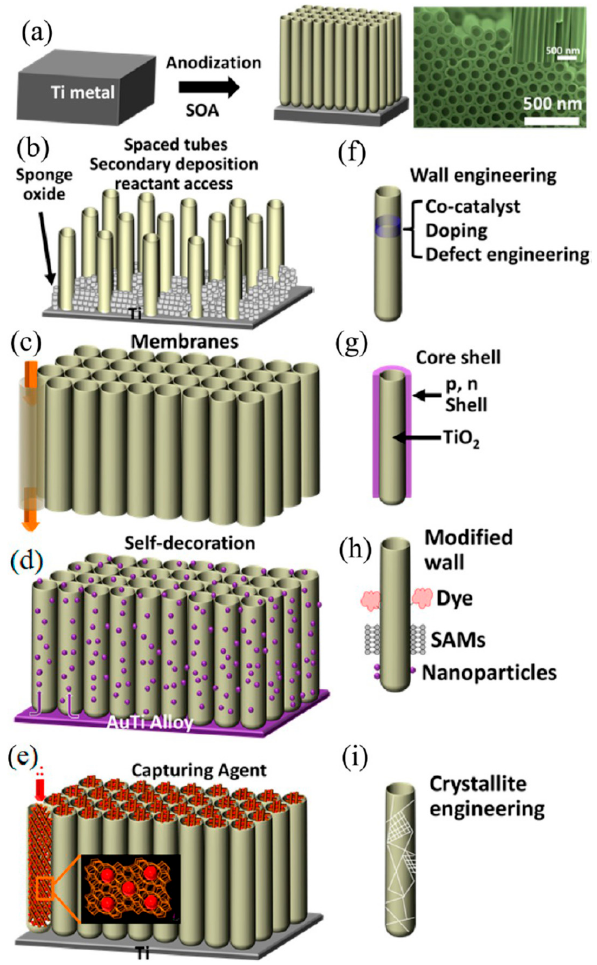
Figure 13. Schematic drawing of ( a , b ) formation and ( c − i ) modification of anodic nanotube arrays (as discussed in the text) [82]. Copyright 2017 American Chemical Society.